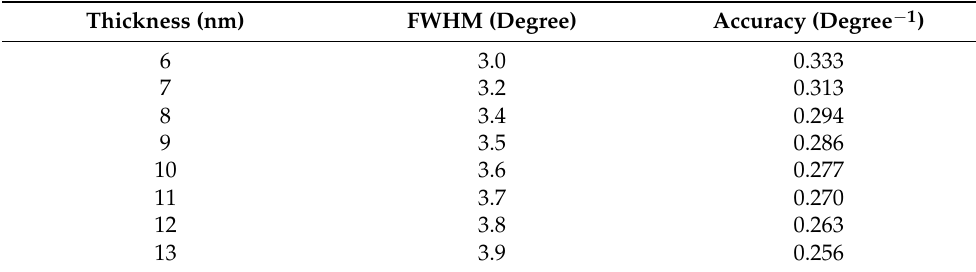
Table 2. The FWHM and accuracy of NCC-based thin film at different thickness.